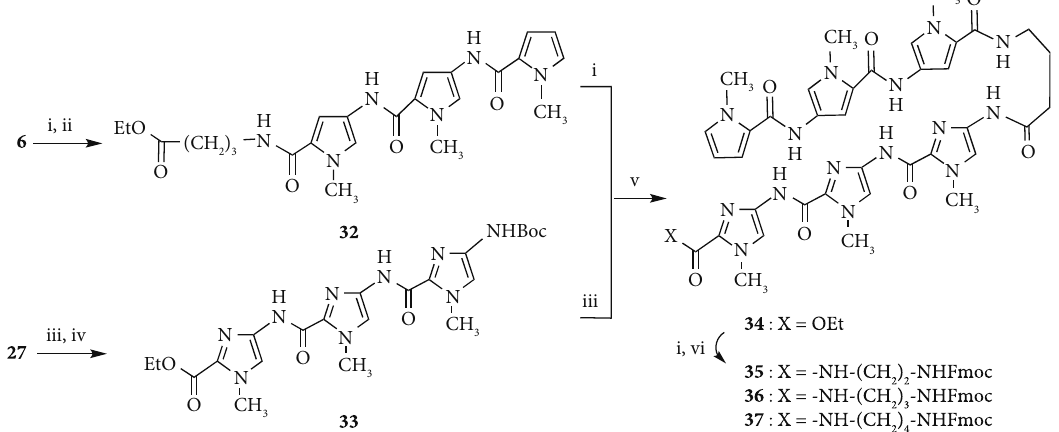
Scheme 6: Synthesis of pyrrole- γ -imidazole polyamide derivatives. Reagents and conditions: i 1 M NaOH aq./EtOH/pyridine, rt; Dowex 50WX8 (H + -form). ii H rt, 33 (70%). v EDCI, DMAP, CH